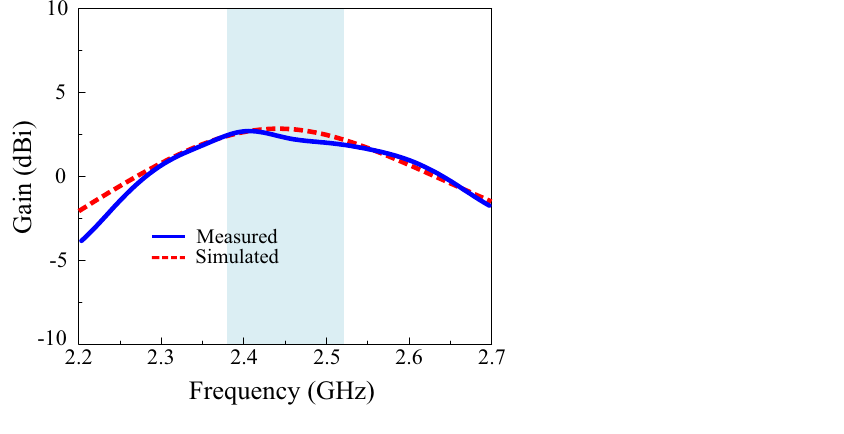
Figure 9. Gain of the